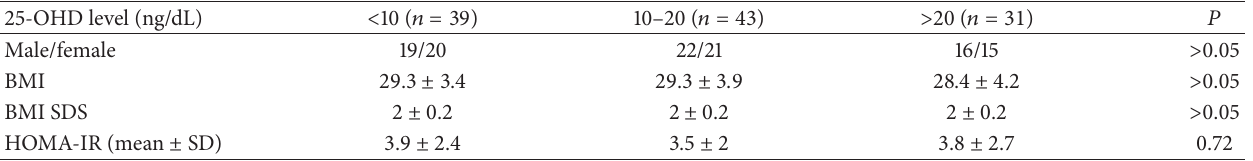
Table 3: The correlation of HOMA-IR and vitamin D levels in obese group ∗ .